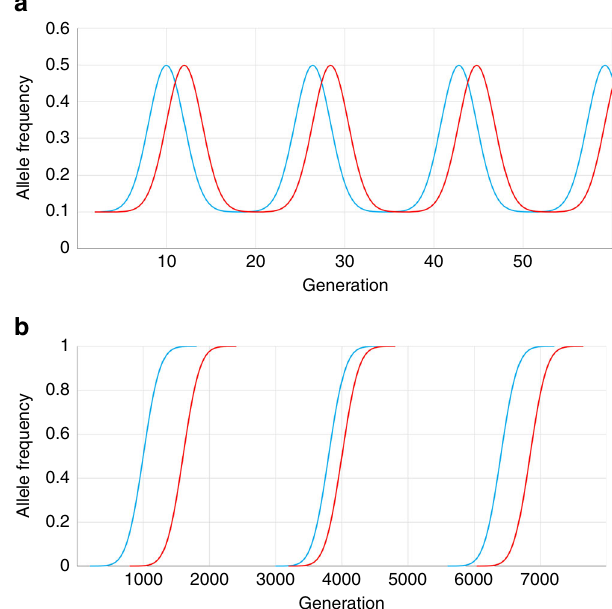
Fig. 1 Allele frequency changes driven by Red Queen co-evolution. a Red Queen dynamics: a dynamic equilibrium of co-evolution acting on host immune alleles (blue) and pathogen virulence alleles (red). This is maintained by balancing selection acting on existing polymorphism over relatively short evolutionary time scales. b Red Queen arms race: recurrent bouts of positive selection in host and pathogen operating on new polymorphisms arising though mutation (adapted from ref. 1